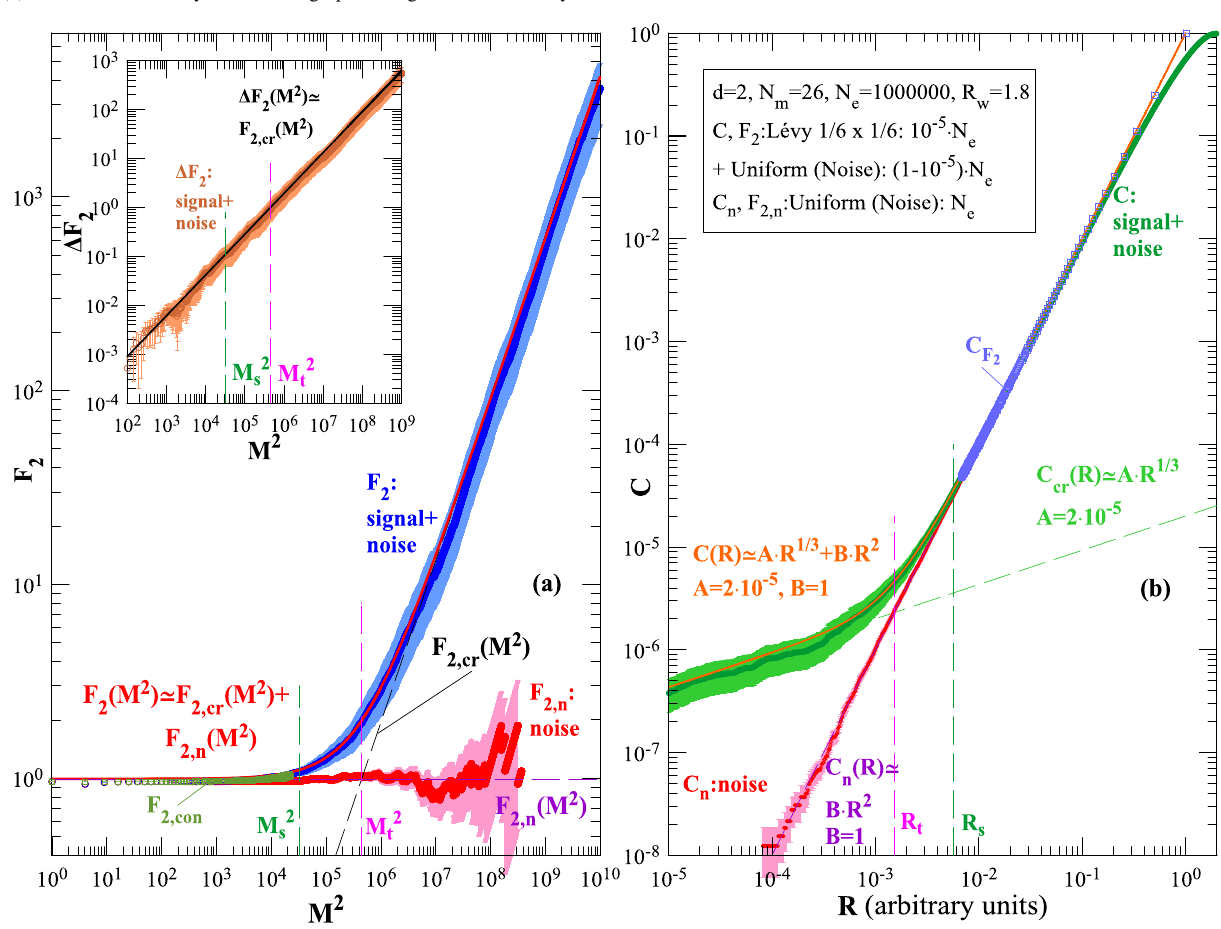
Fig. 15 Analysis of a data set from a simulation in an embedding space of d = 2 dimensions, which contains critical Lévy events of d F = 1 / 3 and a high percentage of noise, which is a uniform distribution with d n = 2. The factorial moments F 2 are depicted in a and the correlation integral C in